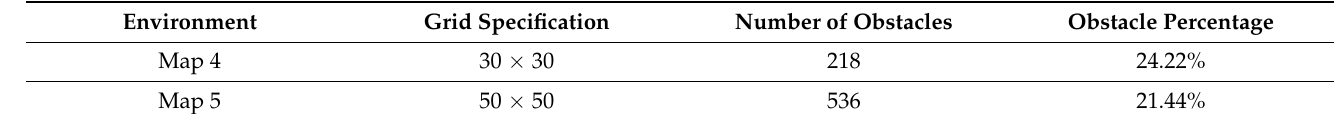
Table 10. Complex experimental environmental parameters.